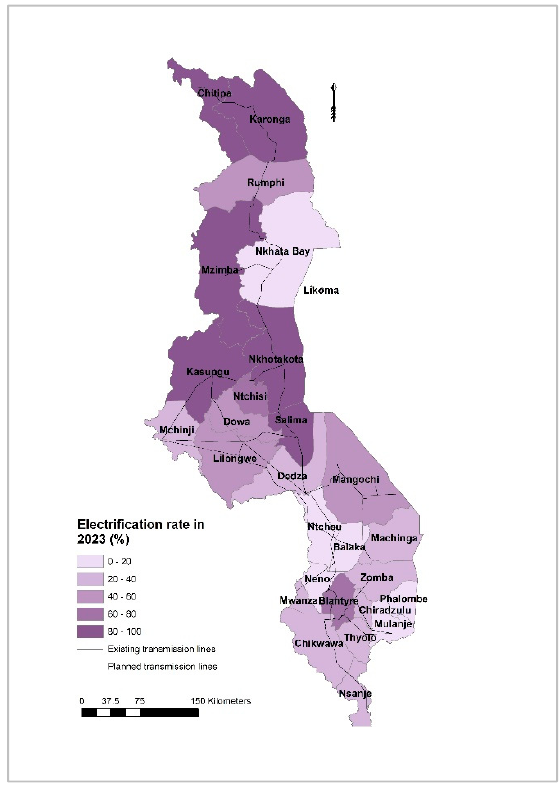
Figure 7. Percentage (%) of electrified population per province as in 2023.